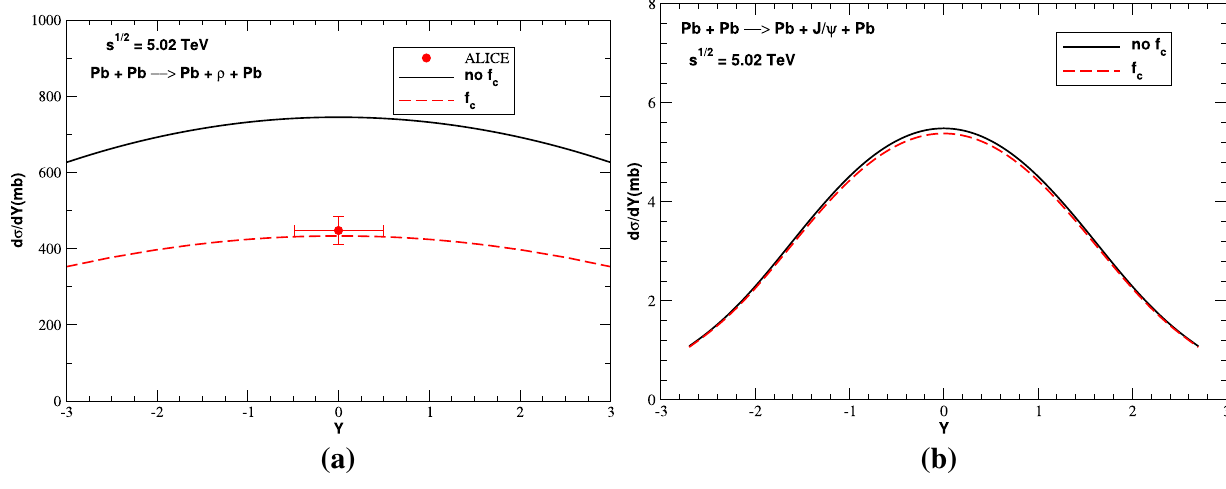
Fig. 5 Rapidity distribution for the exclusive a ρ and b J /(cid:4) photoproduction in PbPb collisions at